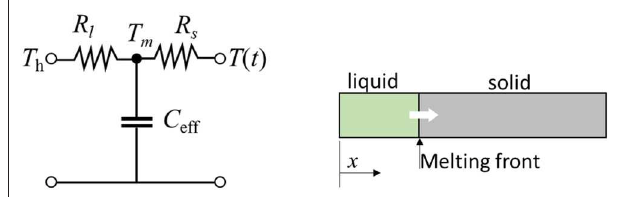
FIGURE 5 | Lumped mass model for a phase-change material (PCM). The equivalent analytic thermal circuit (Left) represents 1-D dynamic thermal storage (Right)